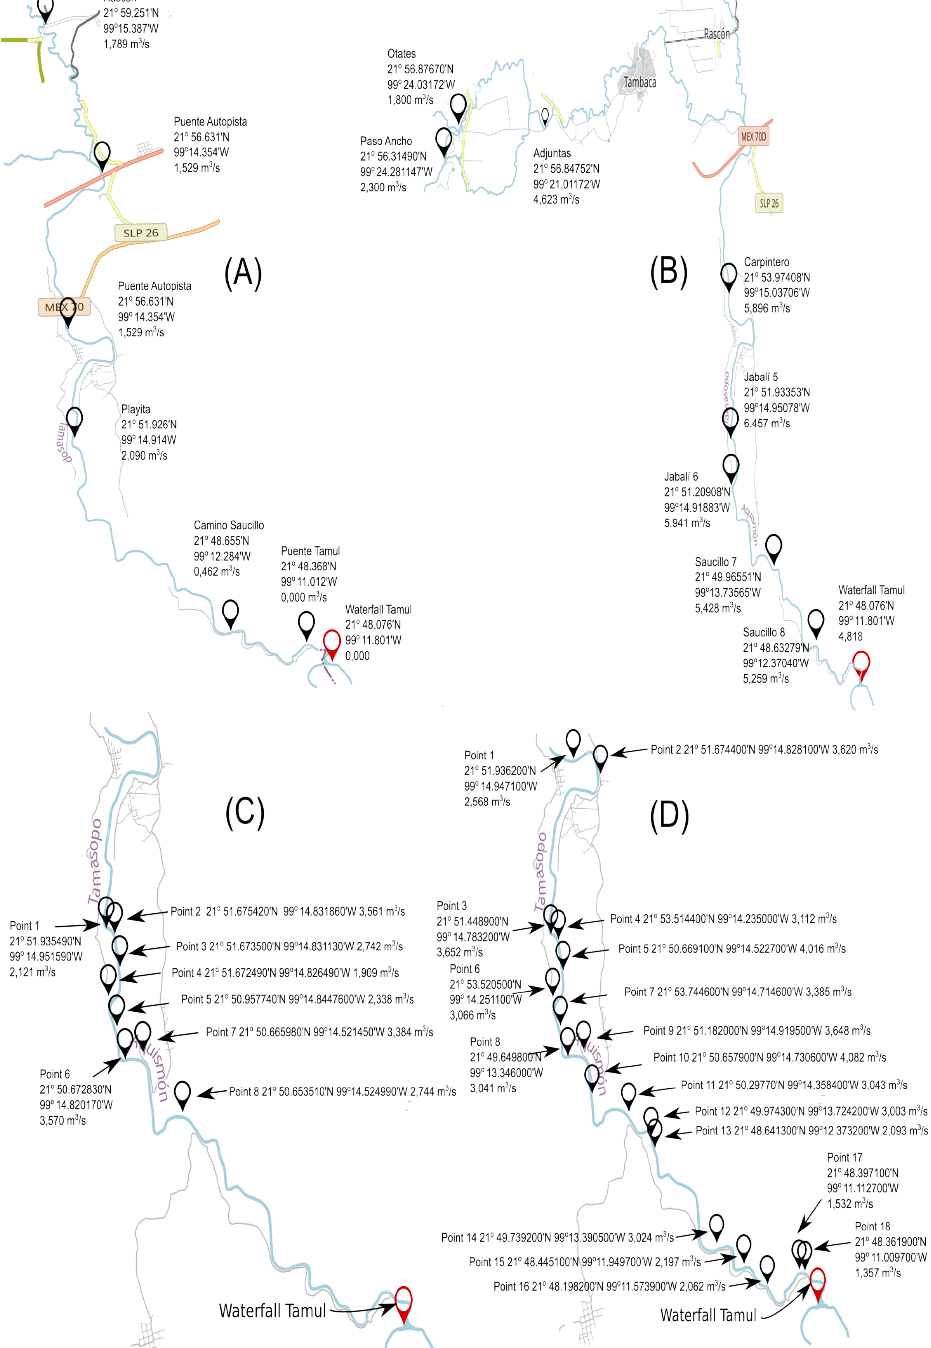
Figure 6. Location of the flow measurement points for the four campaigns. ( A ) First campaign locations. ( B ) Second campaing locations. ( B ) Second campaign locations. ( C ) Third campaing locations. ( D ) Fourth campaign